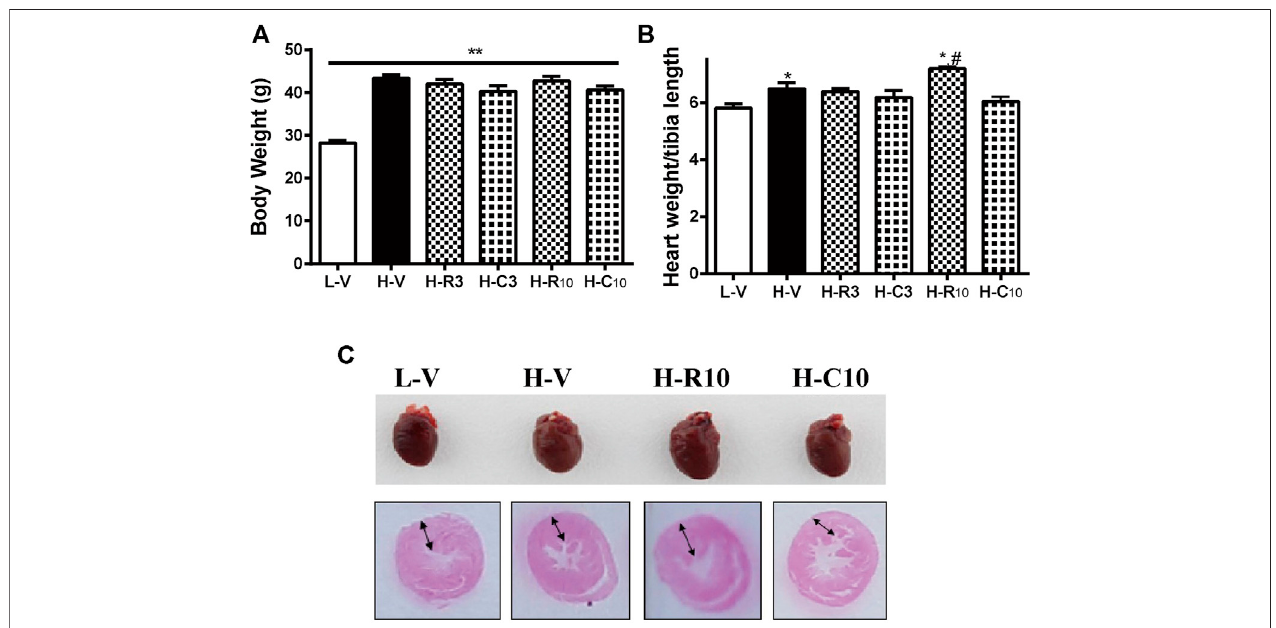
FIGURE 3 | Rosiglitazone and CMHX008 displayed different changes in cardiac weight and overview morphology. (A) The body weight of mice treated with rosiglitazone and CMHX008 under LFD and HFD conditions; (B) Heart weight to body weight in LFD and HFD after treatment with rosiglitazone and CMHX008 under LFD and HFD conditions; (C) Macroscopic view of representative H&E – stained transverse sections from heart tissues. Means ± SEM, n (cid:2) 6 – 10 mice per group, * p < 0.05, ** p < 0.01 vs. L-V; # p < 0.05 vs.